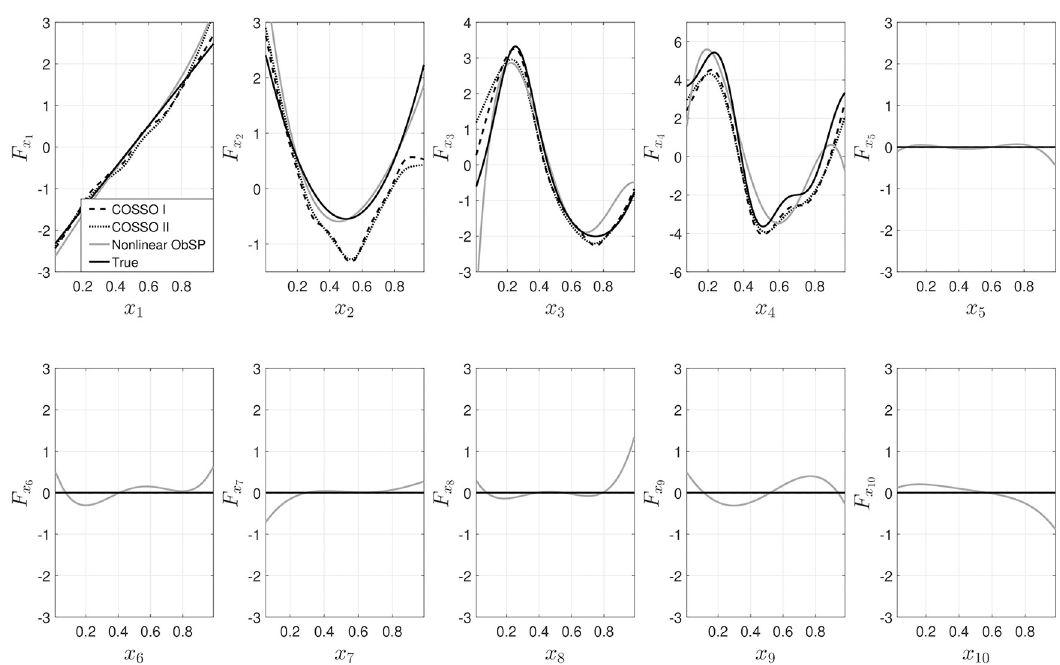
Fig 1. Results from the decomposition of the output for the toy example I using NObSP (gray solid line), COSSO I dashed black line, and COSSO II in a black dotted line. The solid black line represents the true component.